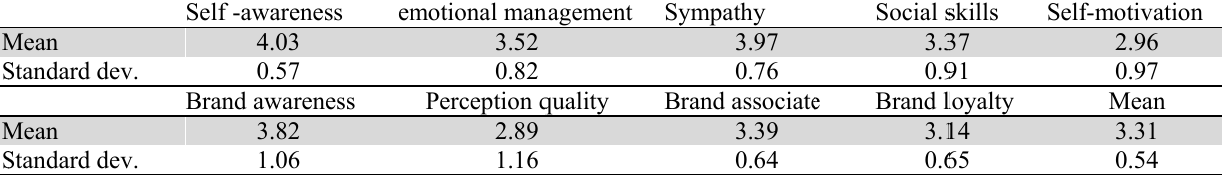
The summar Mean Standard dev. Mean Standard